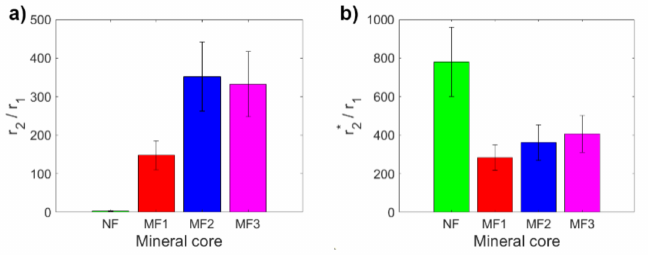
Figure 2. Comparison of relaxivity ratios of NF and MF samples: ( a ) r 2 /r 1 ; ( b ) r 2 * /r 1 .